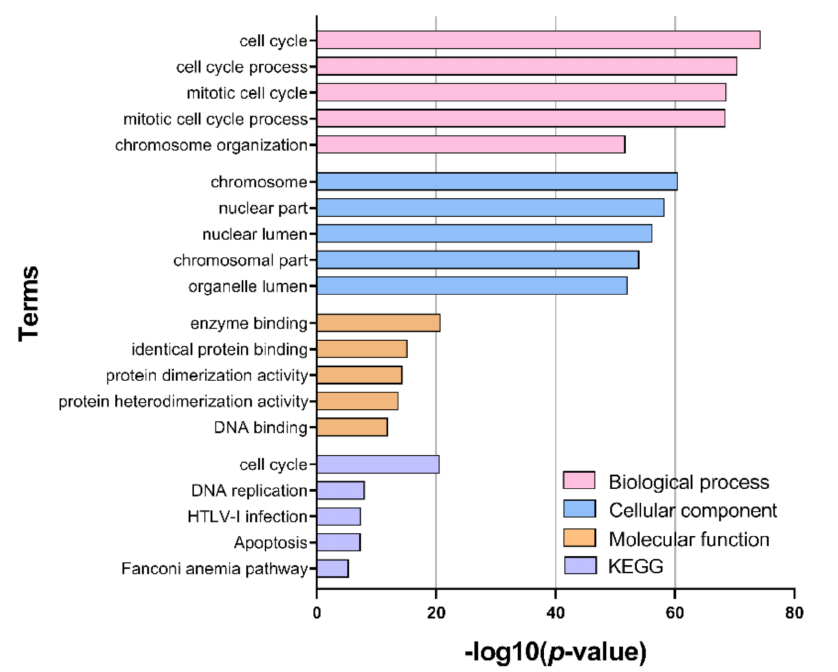
Figure 4. Functional enrichment analysis. Bar plot depicts the top 5 enriched gene ontology (GO) terms within categories: biological process, cellular component, molecular function and KEGG, as identified after performing ClueGO enrichment analysis in Cytoscape with butyrate responsive genes. Y -axis represents the GO term, and the X -axis represents the enrichment significance ( − log10 ( p -value)),